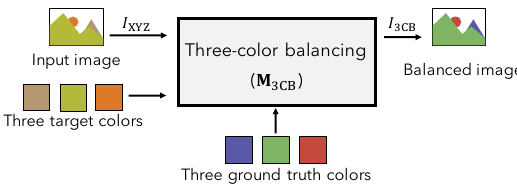
Figure 4. Overview of proposed method.